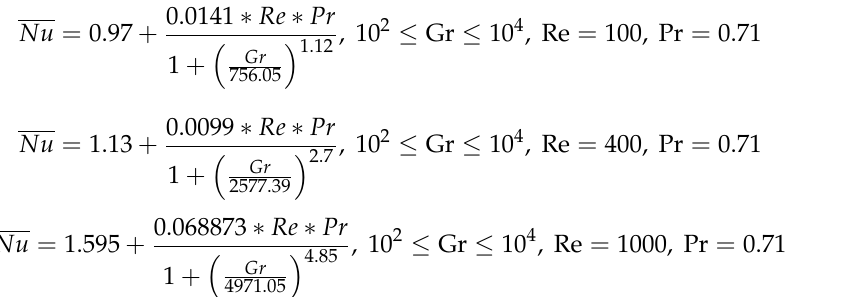
Figure 9. Variation of Nu for different nanoparticles concentration (C) of Al 2 O 3 nanofluid [118,165,204,289–293].